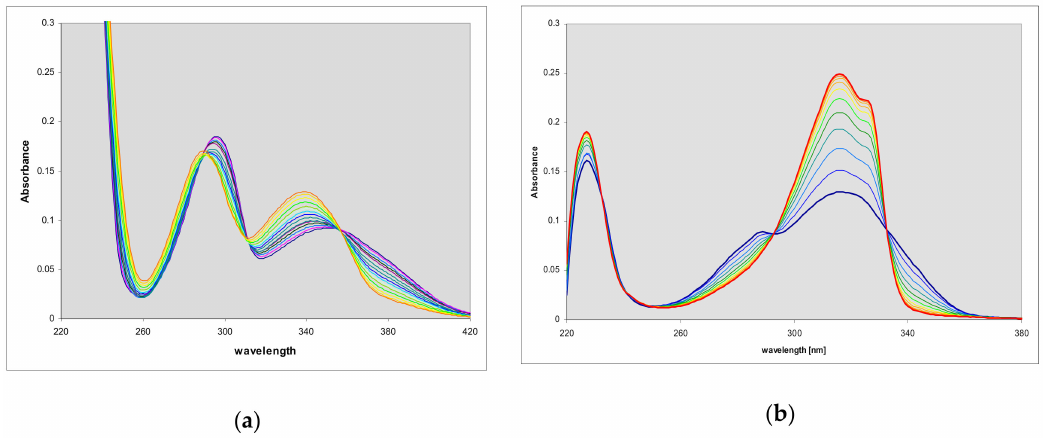
Figure 5. UV absorption changes observed during the enzymatic ribosylation of ( a ) 1,N 2 -etheno- 2-aminopurine ( 1 ) with 0.5 mM R1P, catalyzed by PNP from E. coli ; ( b ) enzymatic ribosylation of N 2 ,3-etheno-2-aminopurine ( 2 ) by the same enzyme under identical conditions. Initial curves are in blue, and the final curves in red. Time intervals were 5 min for ( a ) and 2 min for ( b ).